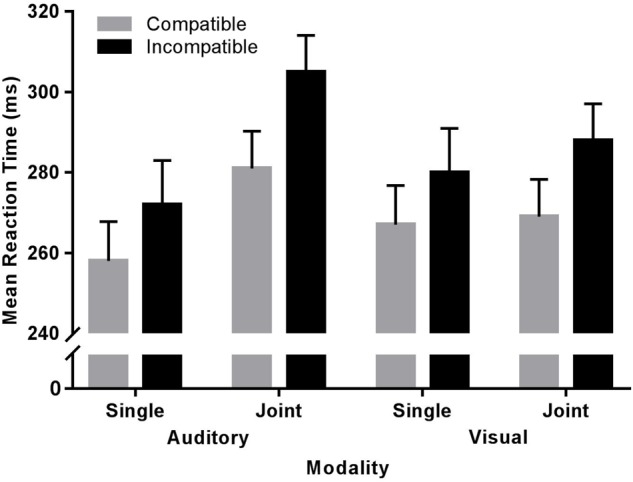
Mean reaction time (ms) as a function of Compatibility (compatible, incompatible), Condition (single, joint) and Modality (auditory, visual). Errors bars represent the standard error (SE).